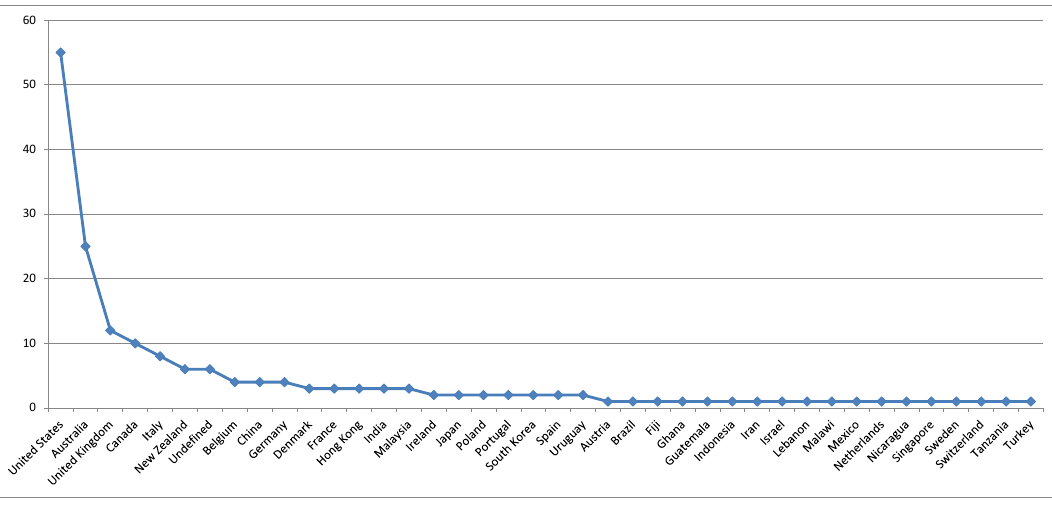
Figure 2. Distribution of the documents across subject areas.